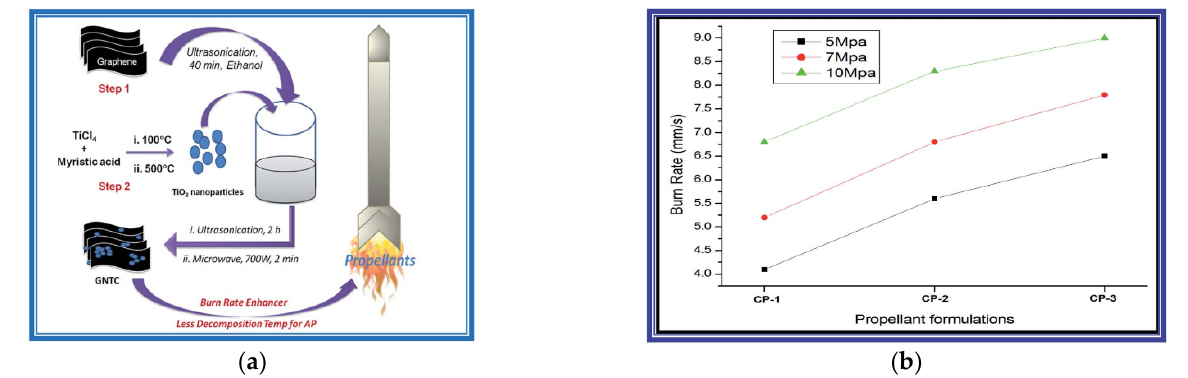
Figure 17. ( a )Schematic representation of the synthesis and application of the graphene–titanium dioxide nanocomposite (GTNC) ( b )Variation of the burn rate with pressure for different propellant compositions. Reprinted from ref. [52].